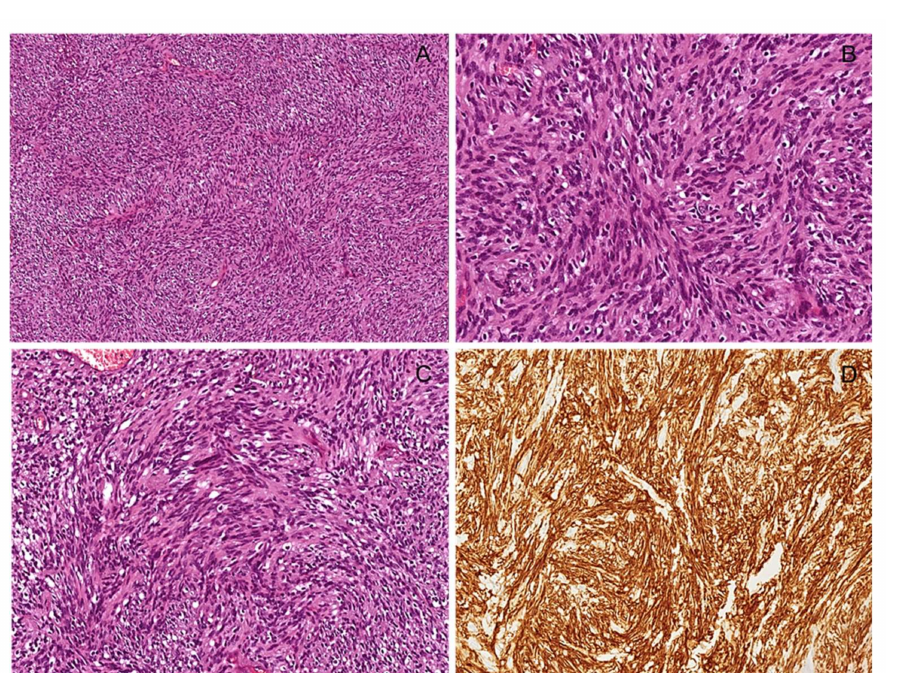
Figure 15. Cellular schwannoma. ( A ) Low-magnification image showing a hypercellular tumor com- posed uniformly of Antoni A areas and lacking hypocellular Antoni B areas. ( B ) Tumor is usually composed of bland-looking spindle cells arranged in short intersecting fascicles. ( C ) As an additional characteristic feature, long sweeping fascicles of spindle cells arranged in a storiform growth pattern may be seen. ( D ) Unlike other spindle cell tumors, tumor cells are diffusely and strongly stained with S100